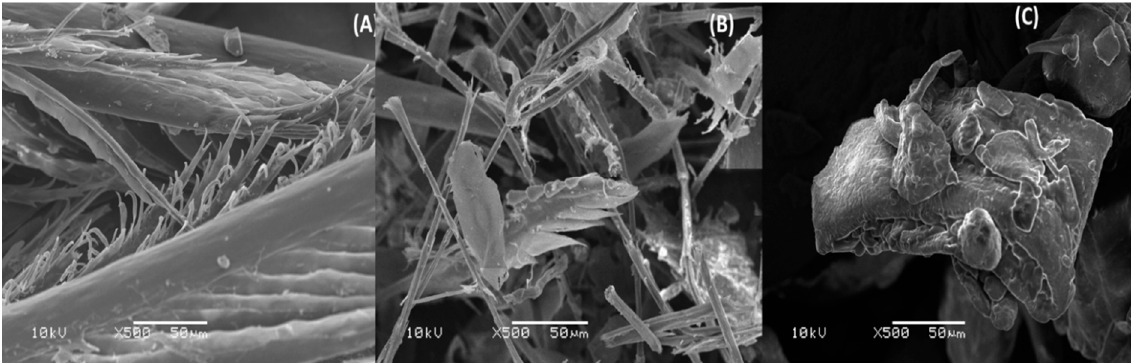
Figure 1. Scanning electron microscopy in natura feather ( A ), Bacillus subtilis hydrolyzed feather meal ( B ) and thermal hydrolyzed feather meal ( C ).